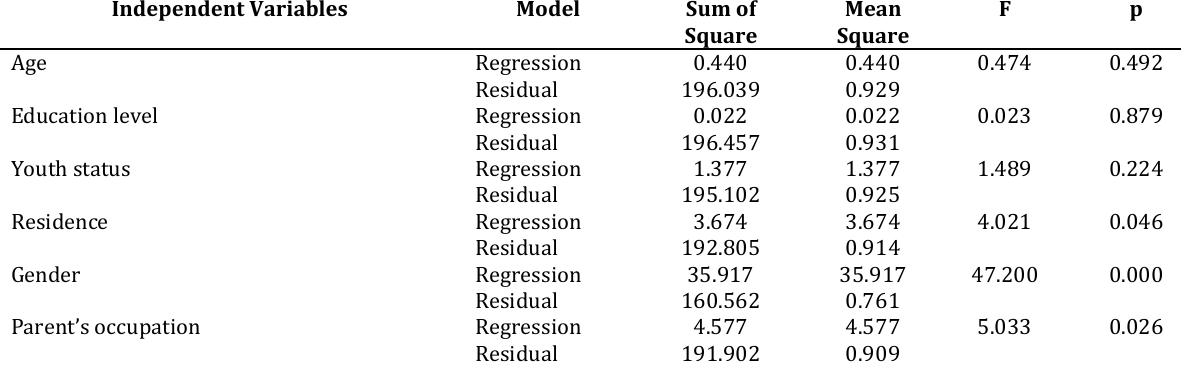
Table 2. The relationship between the independent variable and the dependent variable Independent Variables